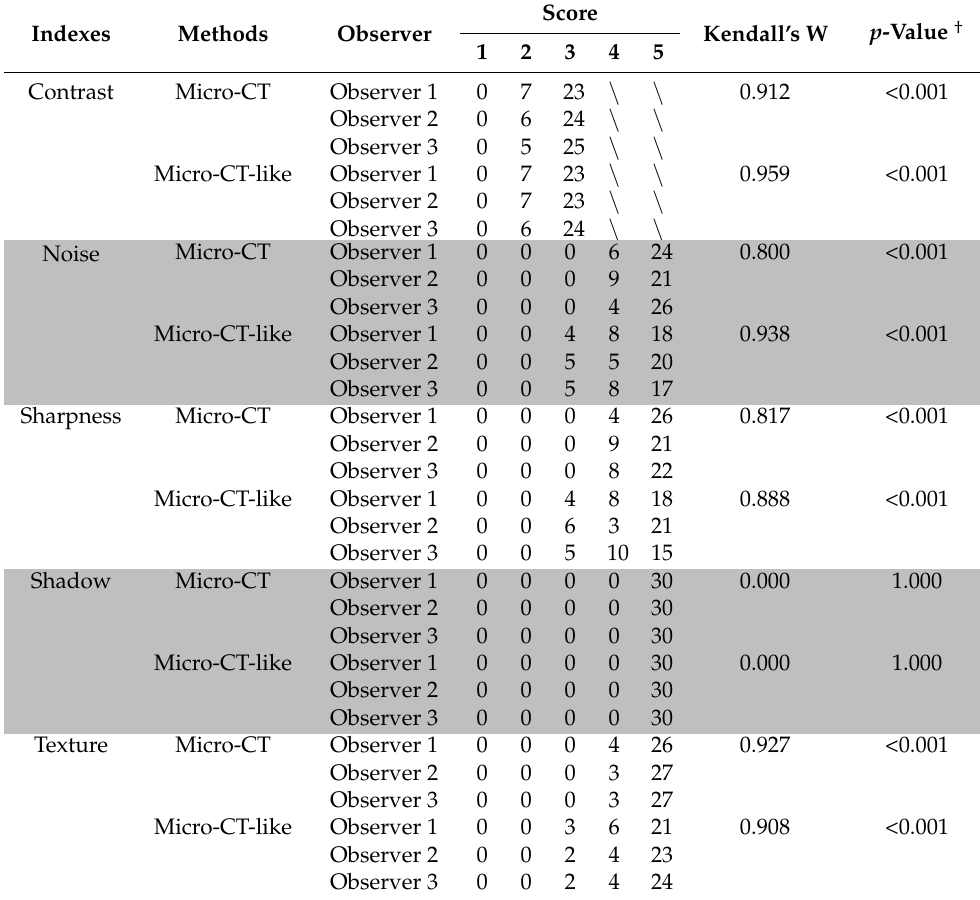
Table 2. Interobserver agreement for subjective assessment scores of micro-CT and pix2pixHD- derived micro-CT-like images.